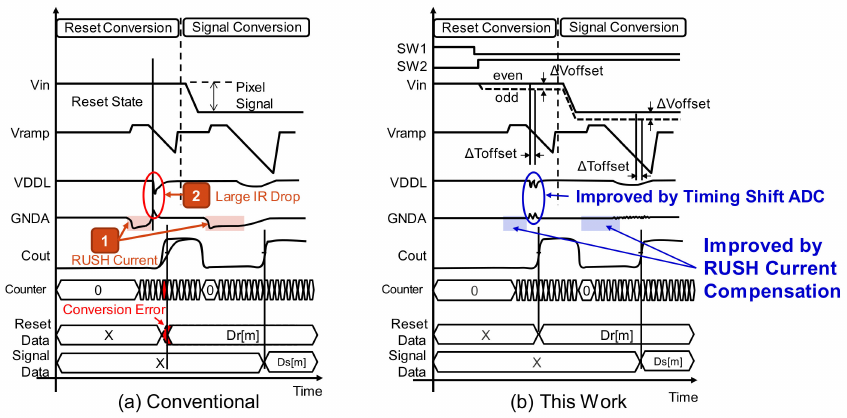
Figure 8. Improvement image by RUSH current compensation and timing shift